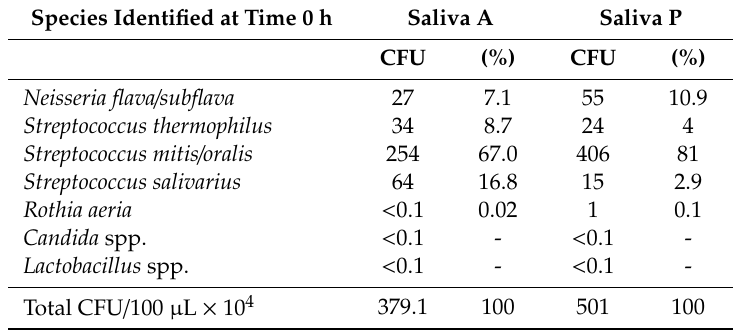
Table 1. Initial microbial load and evaluation of the main microbial species in Saliva A and P. Species Identified at Time 0 h Saliva A Saliva P CFU (%) CFU (%) Neisseria flava / subflava